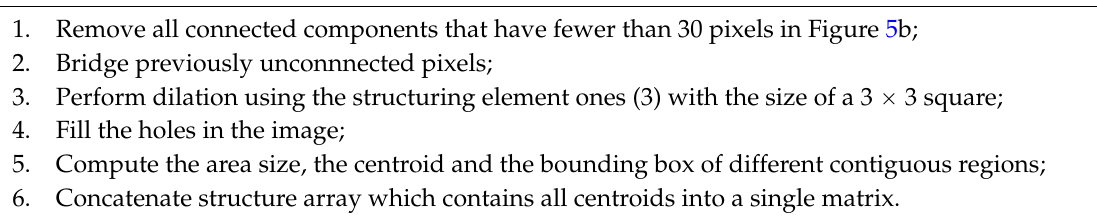
Algorithm 2: Morphological operations for detecting feature centroids